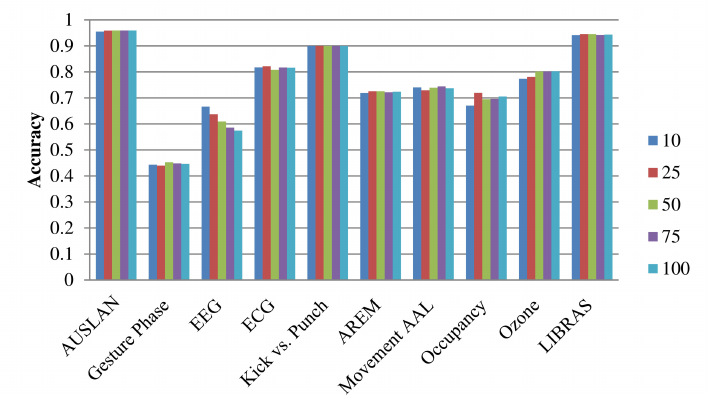
Figure 4. Accuracy of NN-DTW classifier with augmented time-series generated by SPAWNER considering a different number of neighboring sequences in the selection of input sequence pairs. The number of selected time-series is given in